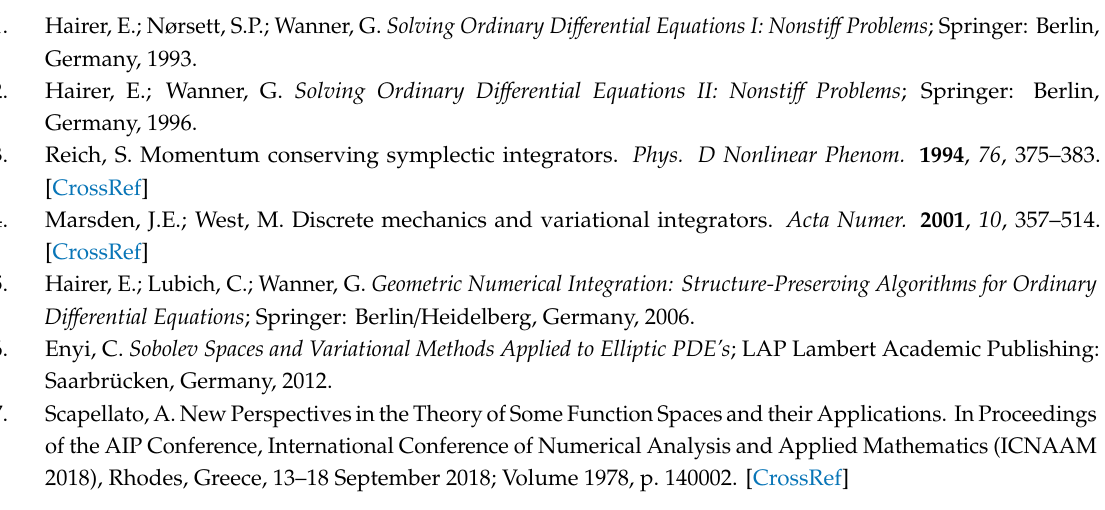
Figure 11. Six balls: Antisymmetric property of the generalized coordinates